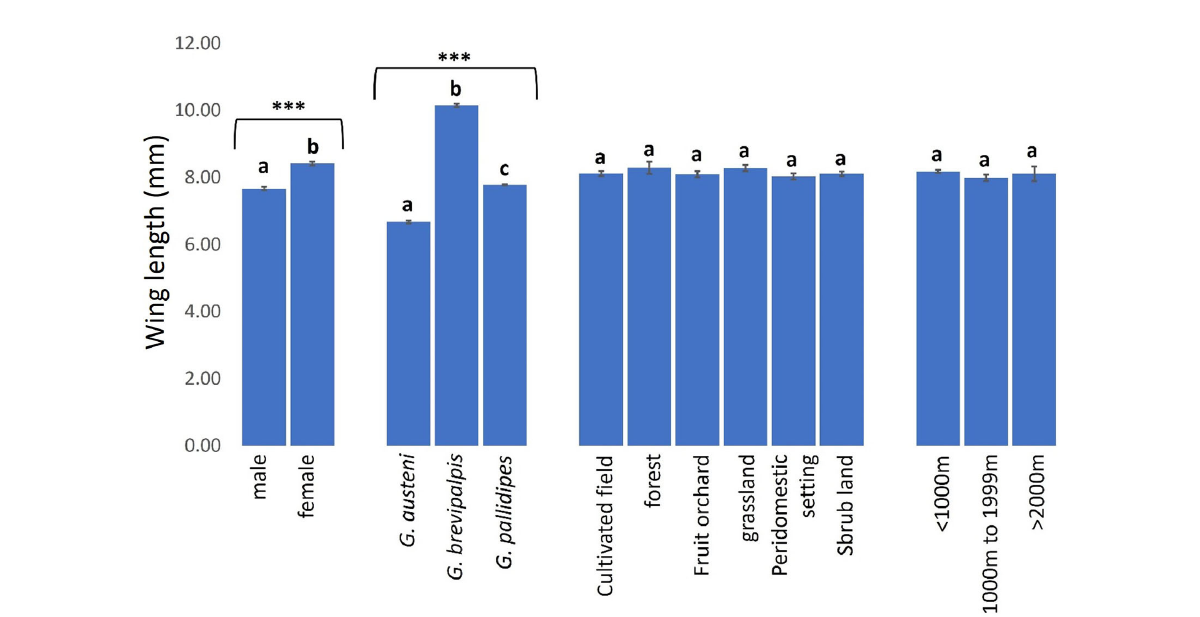
FIGURE9 Wing length of tsetse flies according to fly sex and species and collection site. Error bars are used to indicate the standard error of the mean (SEM). Letters have been used to indicate presence or absence of significant difference in pairwise comparisons of tsetse fly wing lengths of tsetse flies. Pairwise comparisons are made between tsetse flies within the same group defined by sex, species, vegetation site or distance from the wildlife reserve. Significantly different pairs are denoted using different letters while insignificantly different pairs are indicated using same letters. **Indicates P value < 0.0001.